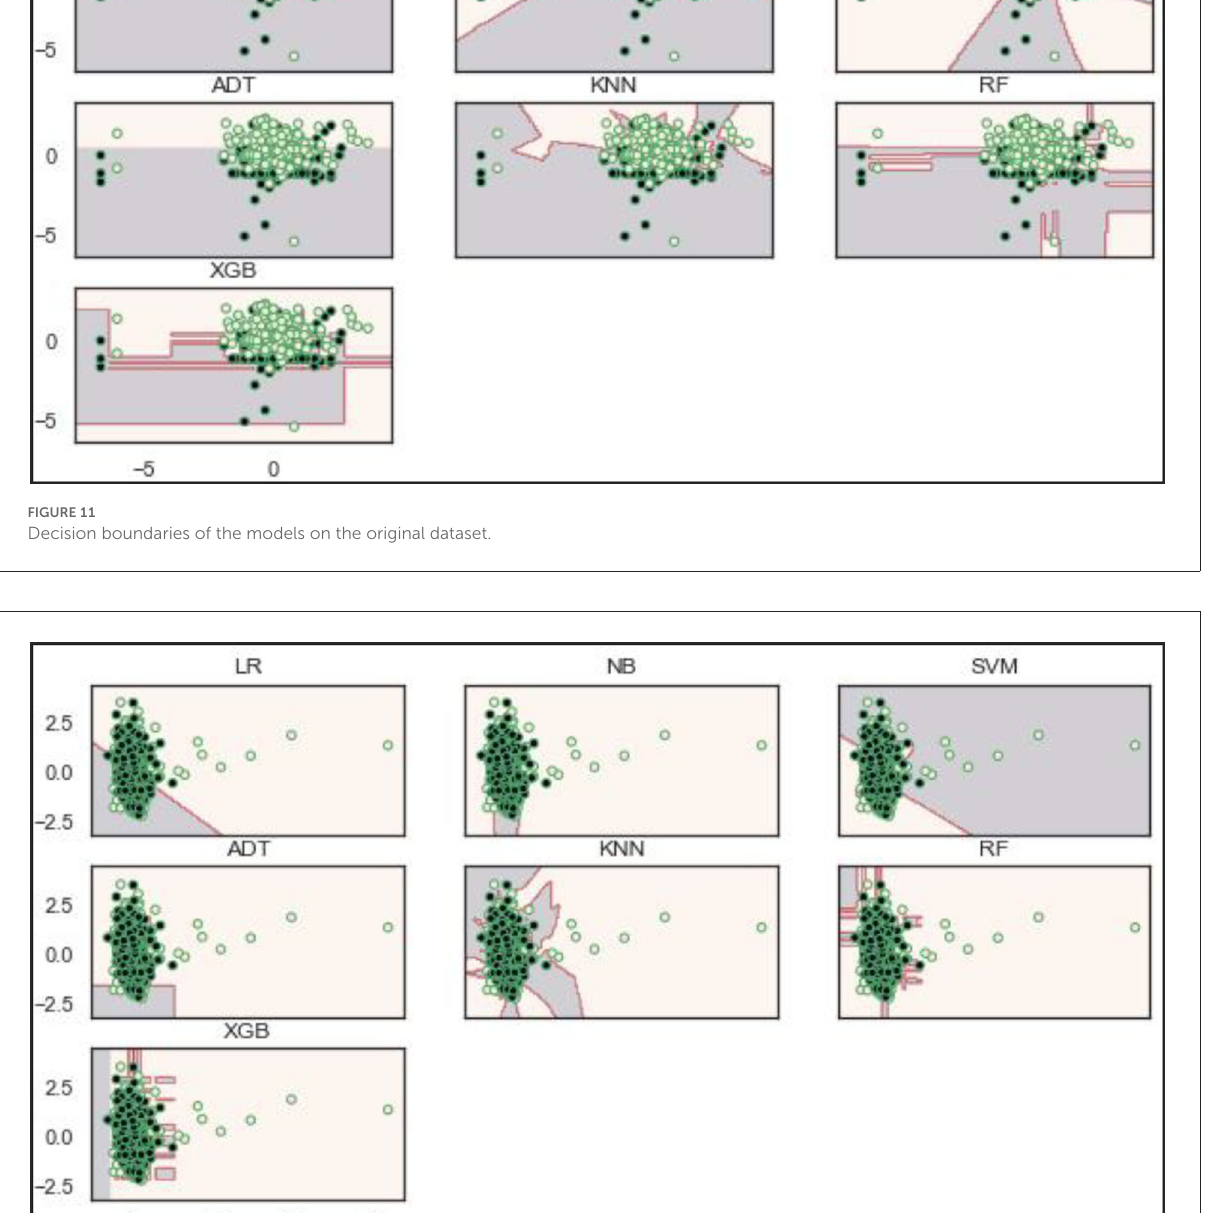
each iteration to alleviate overfitting and speed up computation. In addition to the RF and XGBoost models, ADT also achieved better performance on the SMOTE balanced